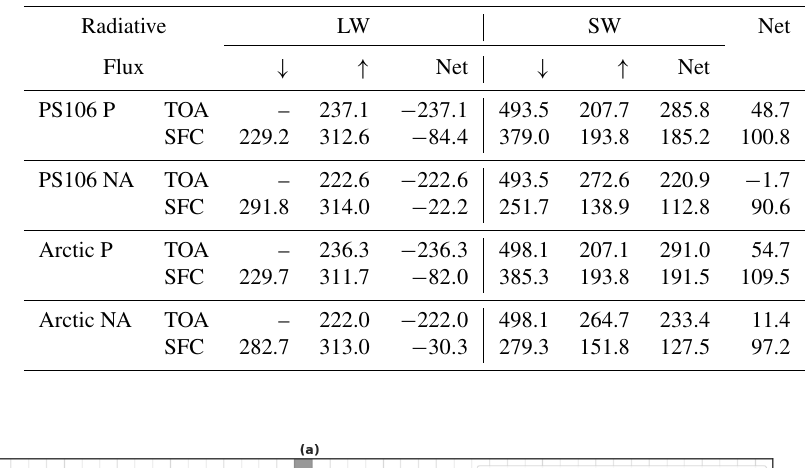
Table B2. Radiation budget for PS106 for pristine (P) and cloudy without aerosols (NA) conditions based on the CERES SYN1deg data set